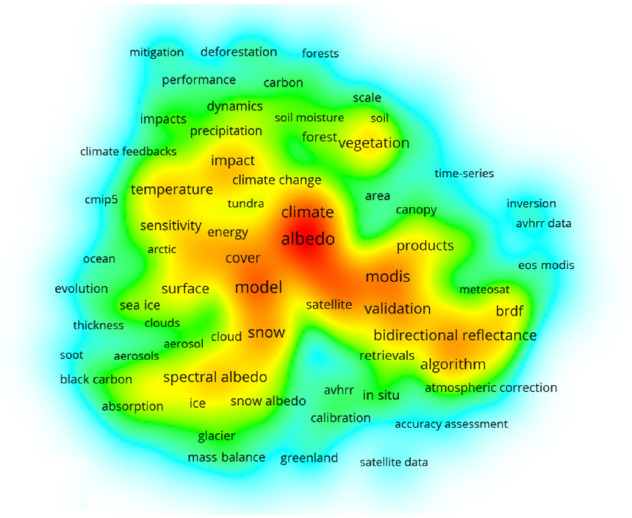
Figure 5. Density plot of keywords. Colouring from red to blue indicates decreasing frequency.